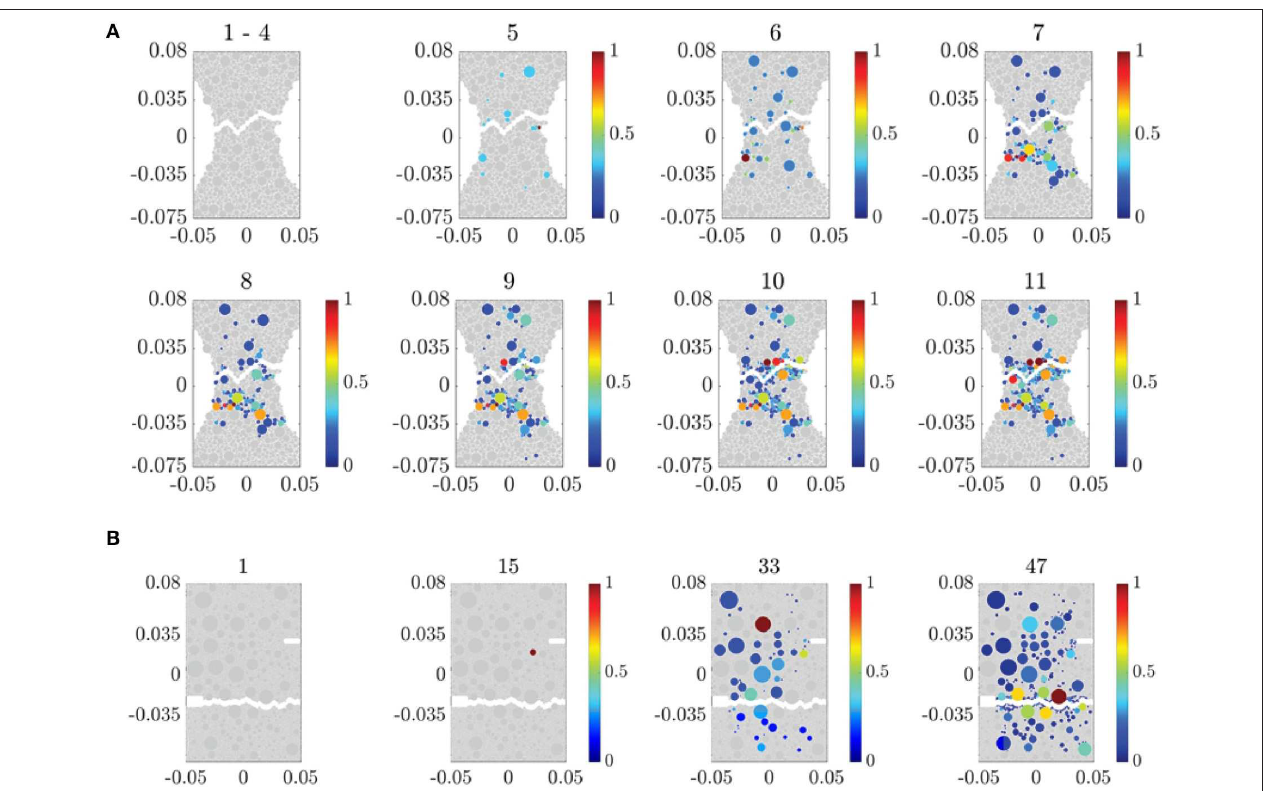
FIGURE 3 | (Color online) Spatial distribution of grain damage. Map of the ratio of the number of broken bonded contacts to the initial number of bonded contacts d p . (A) DI and (B) DII. Undamaged grains, d p = 0, are colored gray. Damaged grains, d p > 0, are colored according to d p normalized to its maximum value for the given stage. An artificial separation between the grains on either side of the macrocrack that develops after peak load is introduced to aid a visual comparison with the particles that sustained damage. Damage below (above) the separation dominates over stages 7–8 for DI (stages 32–33 for